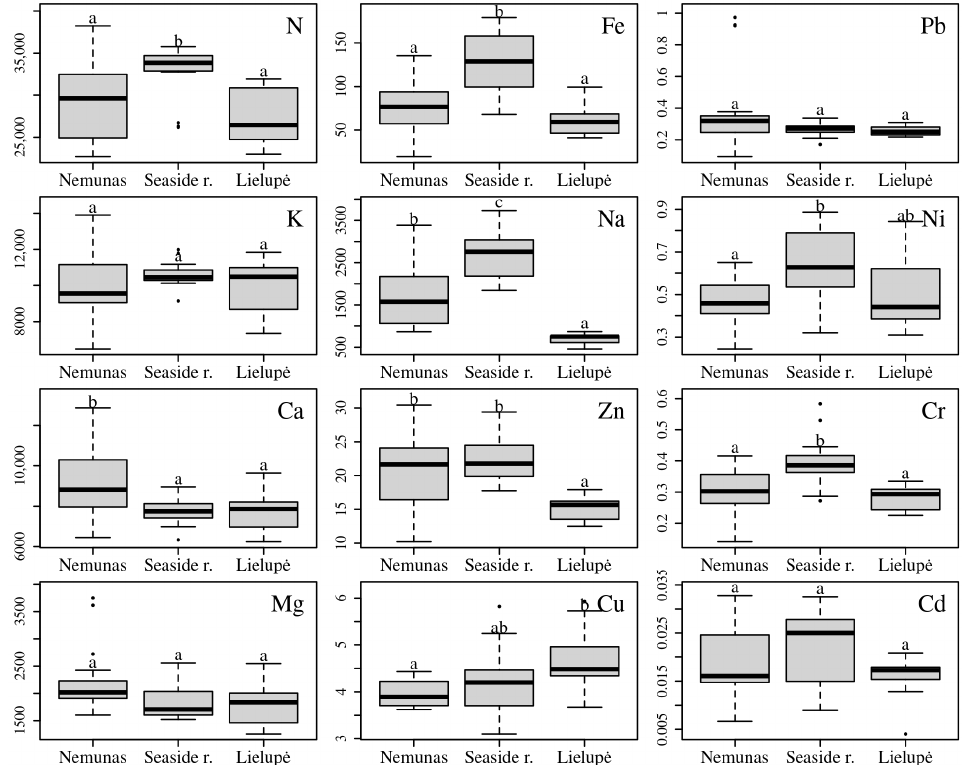
Figure 3. Median values (box–whisker plots) of the leaf element concentrations (µg/g d. m. in y axes) of L. salicaria populations, growing in the Nemunas, Seaside Rivers and Lielup˙e basins. The central line of each box indicates the median value; the boxes, the lower (25%) and upper (75%) quartiles; the whiskers are from the 10th to the 90th percentile (typical range); the points are outliers. Population groups marked with different letters differ significantly ( p < 0.05).